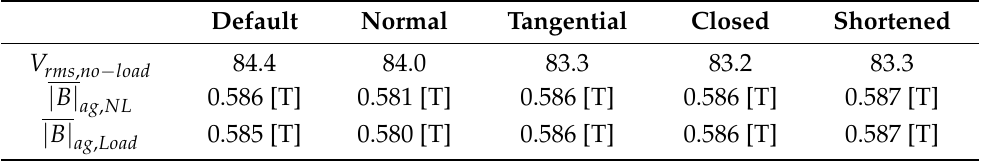
Table 7. Induced voltage and air gap flux density magnitude for the rotating machine under no-load(NL) and